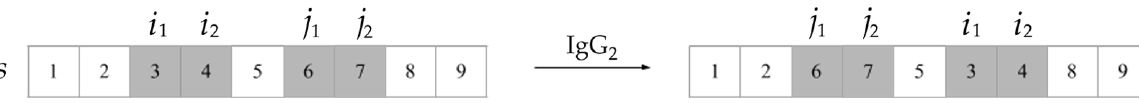
Figure 8. The operation of IgG 2 mode.